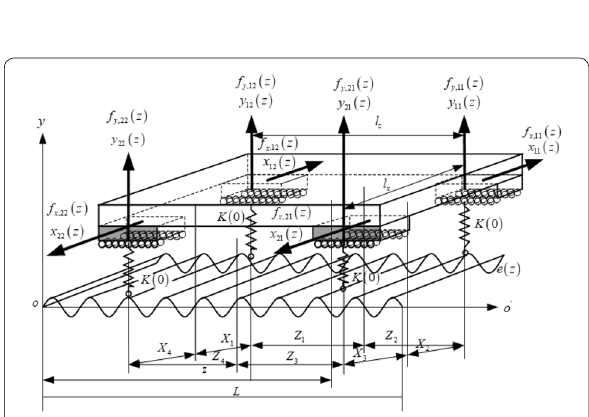
Figure 9 Model of a linear motion bearing table for static